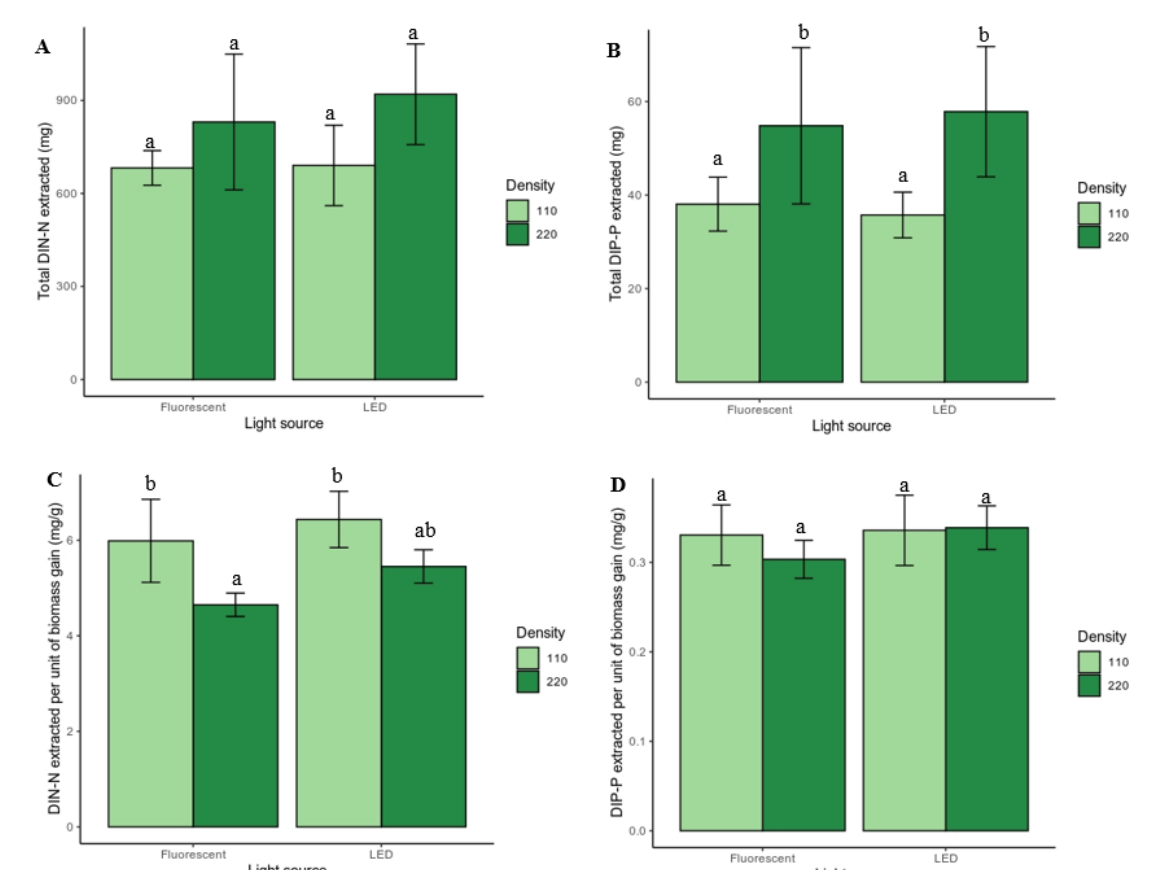
Figure 4. Total quantity of extracted ( A ) DIN–N and ( B ) DIP-P and relative quantity (per biomass gain) of extracted ( C ) DIN–N and ( D ) DIP–P ( n = 5). Bars represent standard deviations. Different letters (a,b) indicate significant differences between treatments ( p < 0.05).